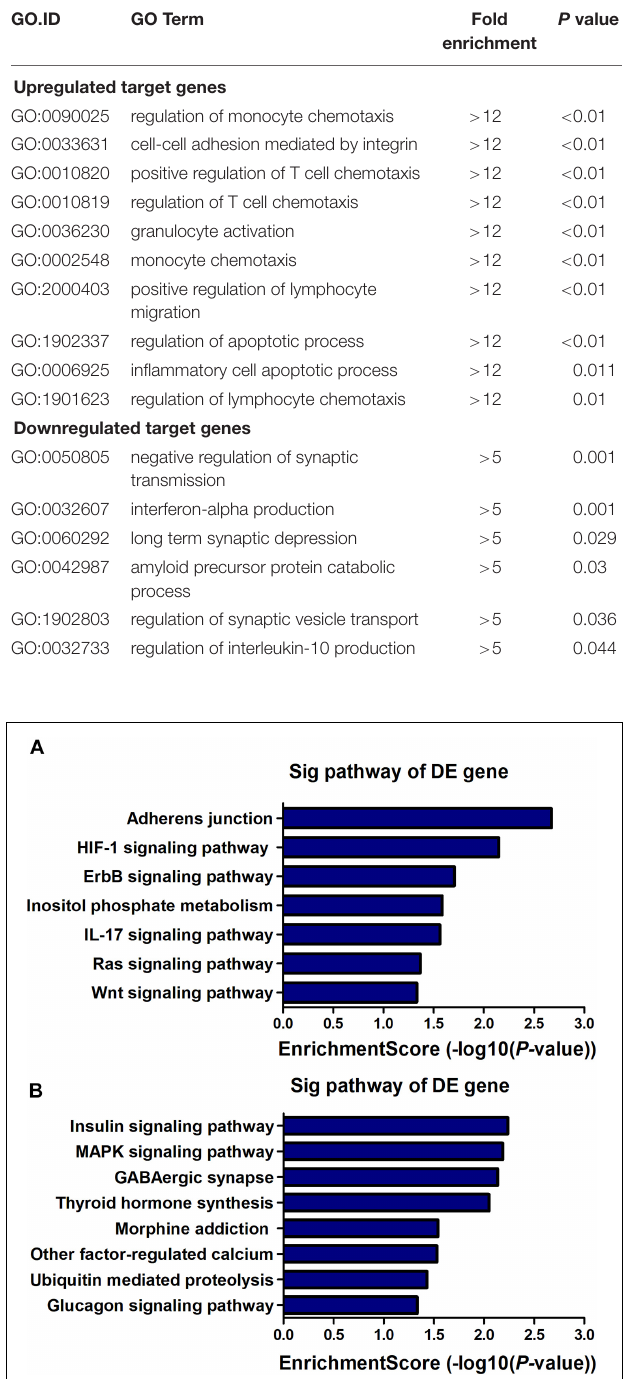
FIGURE 4 | KEGG pathway enrichment analysis is a functional analysis for mRNAs. The P -value (EASE-score, Fisher- P- value or Hypergeometric- P -value) indicates the significance of the pathway correlated to the conditions. The lower the P -value, the more significant the pathway is (The recommended P -value cut-off is 0.05). (A) Pathways involved in up-regulated transcripts. (B) Pathways involved in down-regulated